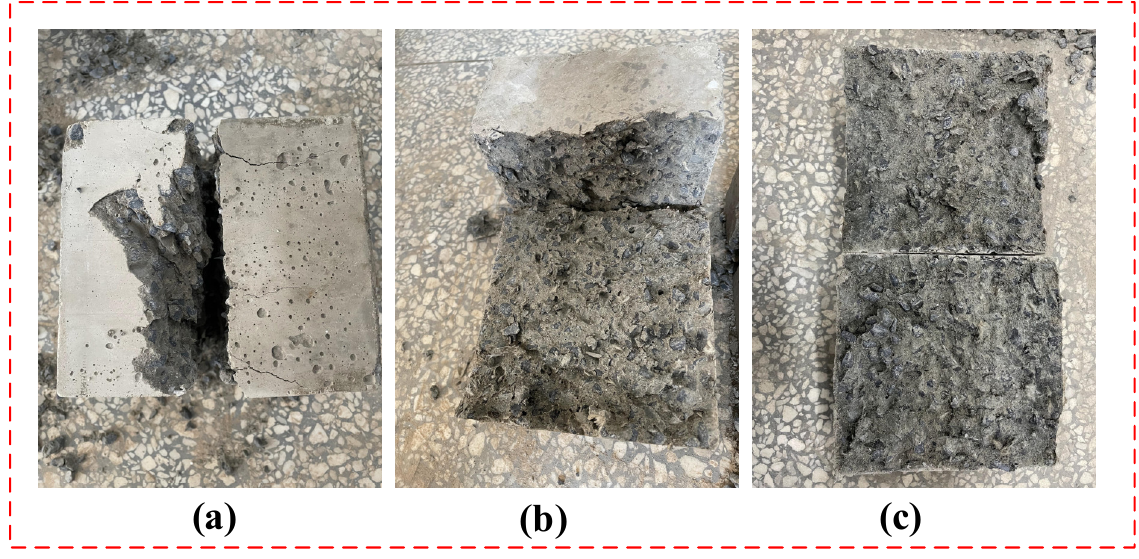
Figure 5. Failure modes in splitting tensile tests: ( a ) Plain concrete; ( b ) Rubber concrete; ( c ) PVA rubber/concrete.